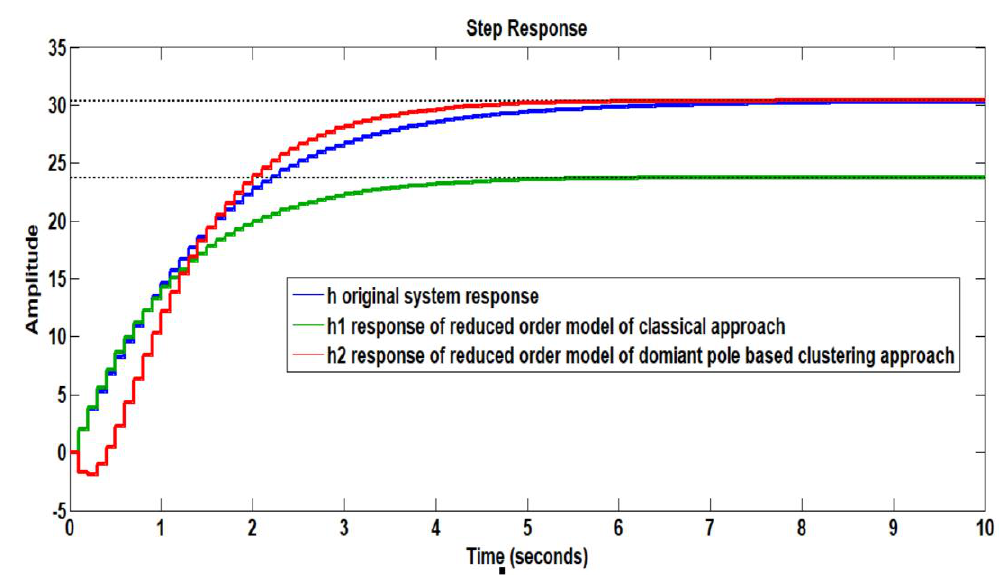
Figure 2. Step response of the original higher order system and reduced order system Eq. (22) is the reduced order model obtained using Dominant Pole Based Clustering